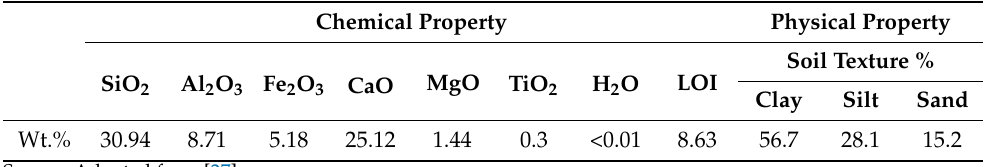
pzc ) of Odaracha